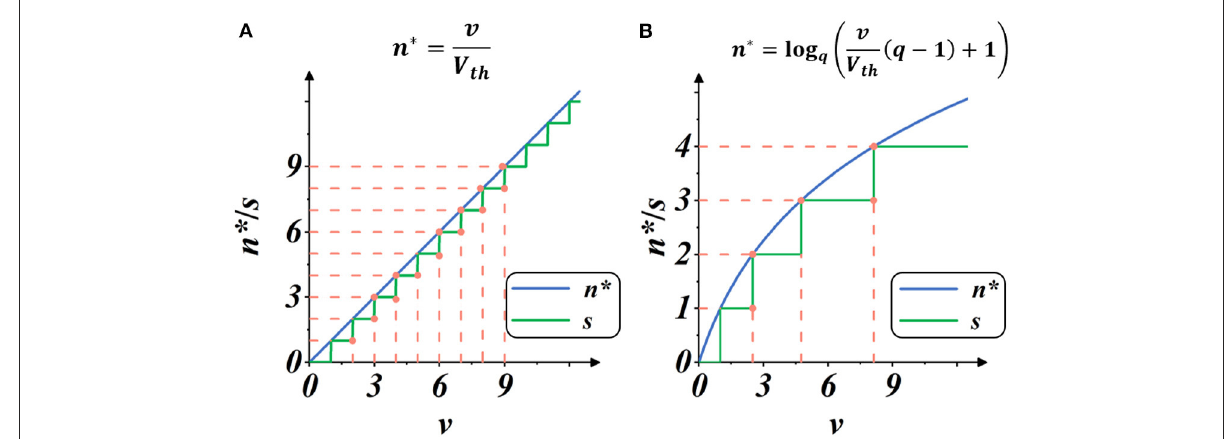
FIGURE4 Plots of spike gate function s = g ( v ) (Equation 10): the spike activity vs. membrane potential. The blue plot indicates the continuous estimate of the spike intensity n ∗ , and the green plot indicates the discrete count of the spike activities s . The threshold is set as V th = 1. (A) Spike activities in Linear mode. (B) Spike activities in Spike Frequency Adaption mode with q = 1.5.